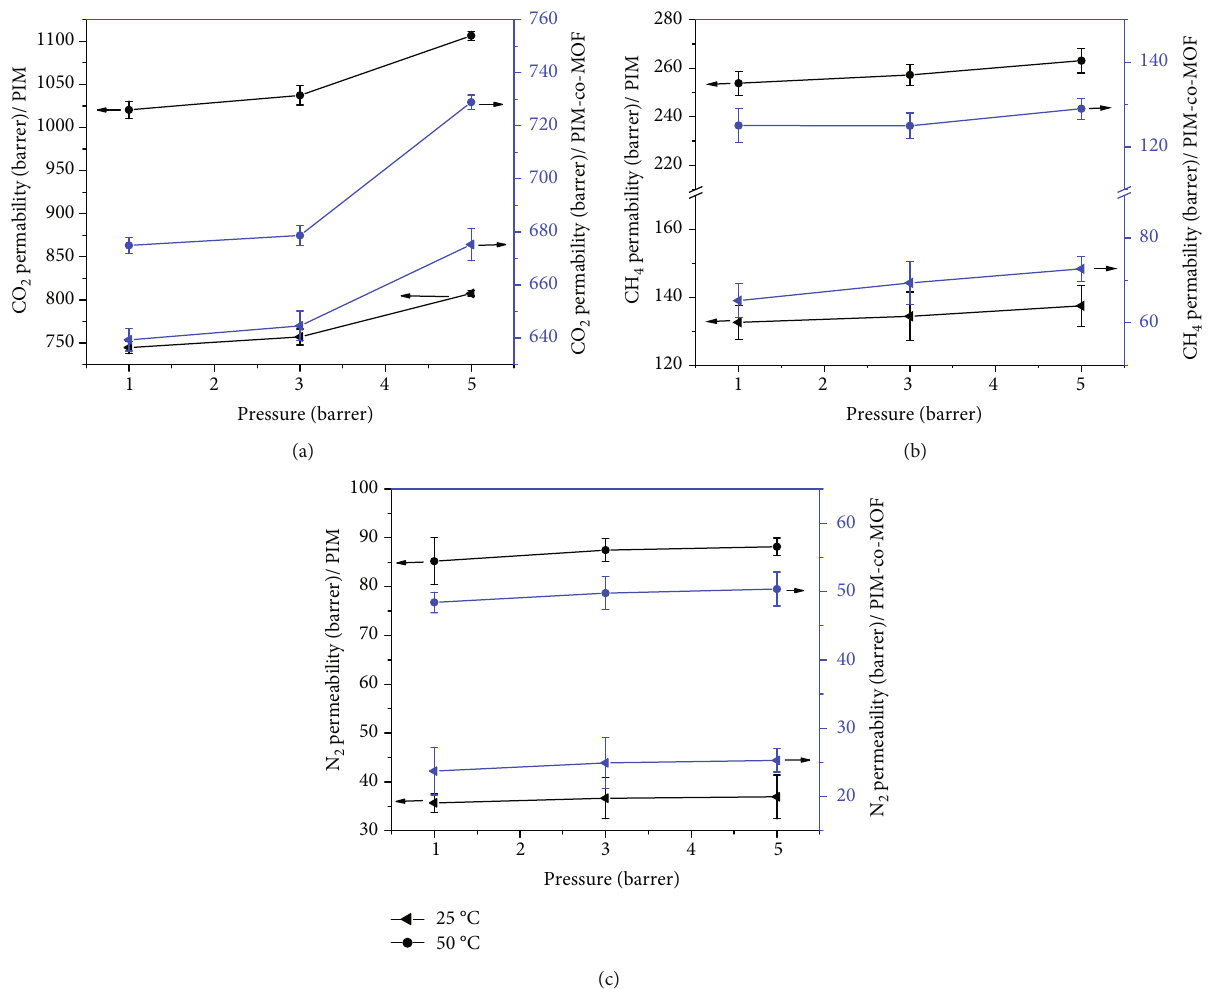
Figure 13: The permeability of the PIM and PIM-co-MOF as a function of feed